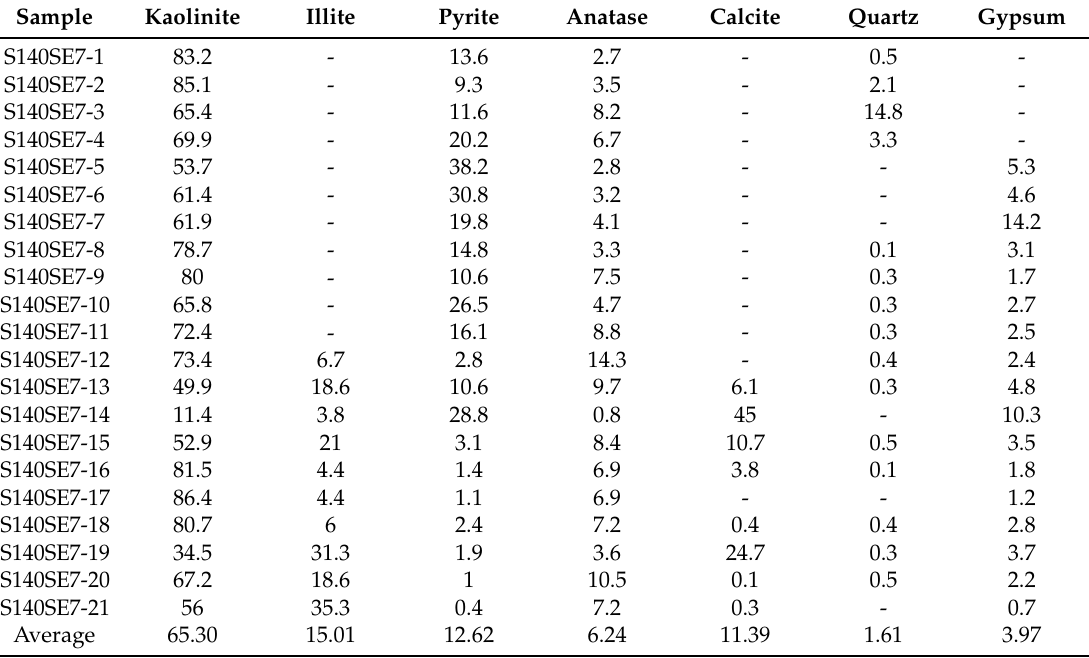
Table 1. Mineral compositions of Tuff by XRD analysis and Siroquant